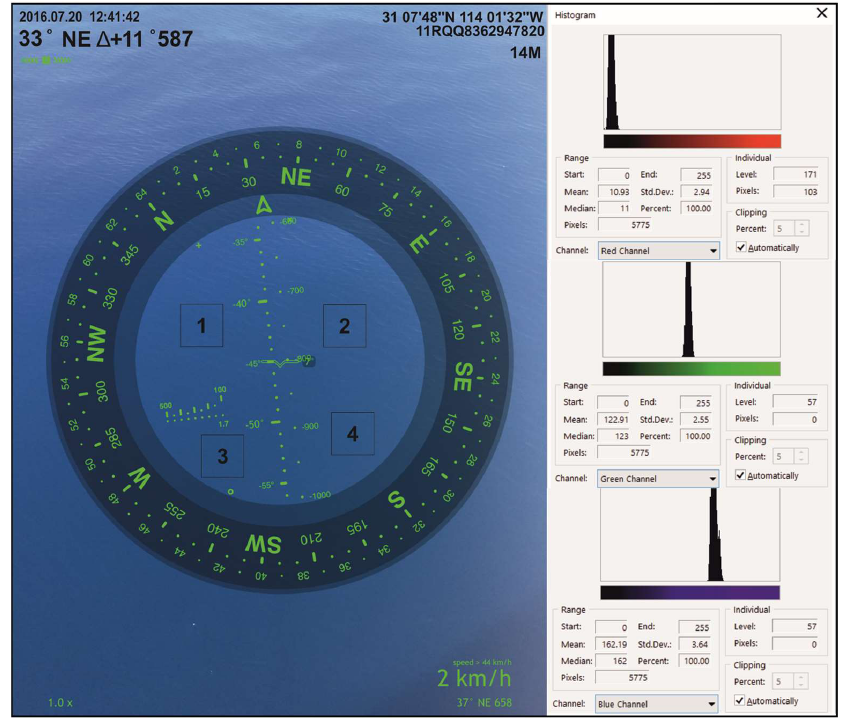
Figure 3. Example of digital photo processing. The four quadrants selected and the histograms used from this image to obtain the average digital values (R, G, B) are shown. To estimate the Forel–Ule scale for each station, we applied the criteria of Novoa et al. [60], and the digital values (R, G, B) were converted to chromaticity coordinates ( x, y,